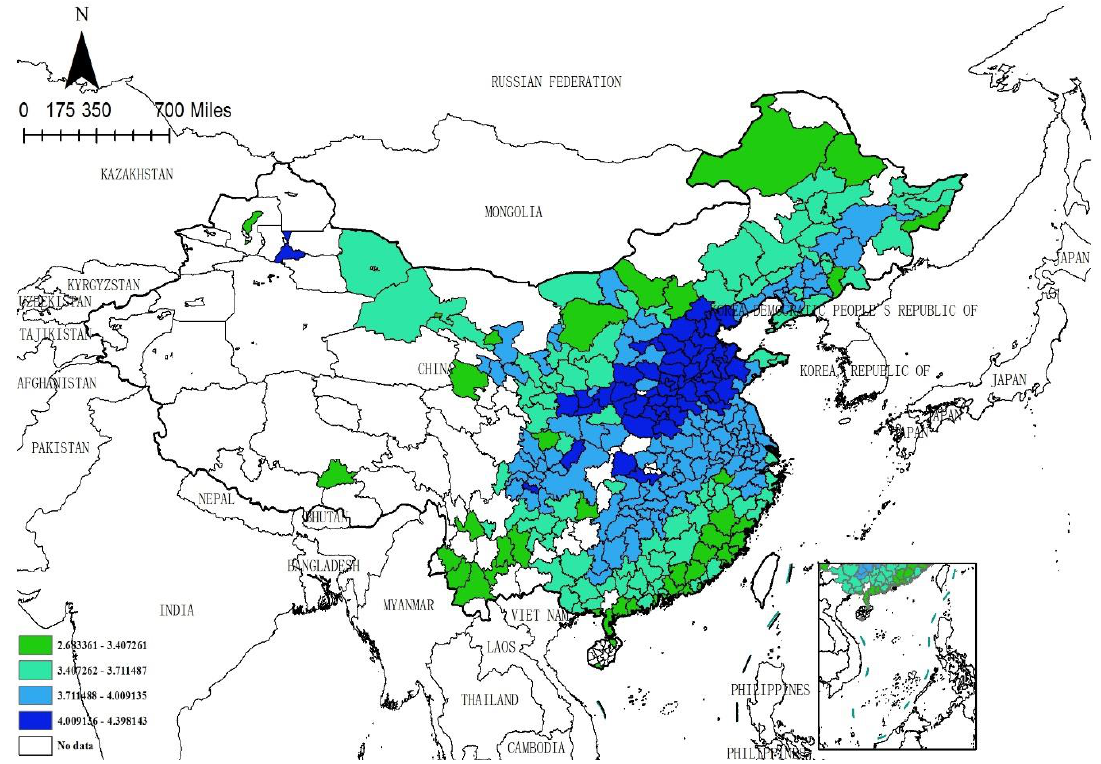
Figure 4. Air pollution distribution. Note: The arithmetic mean values of the air pollution index (2004 – 2020) is adopted.